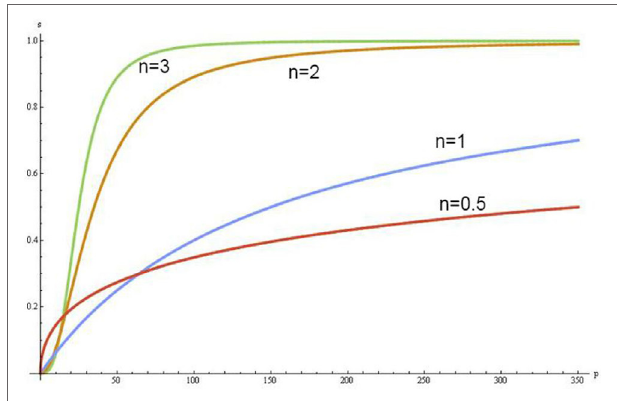
FigURE 1 | Oxyhemoglobin dissociation curves according to different Hill